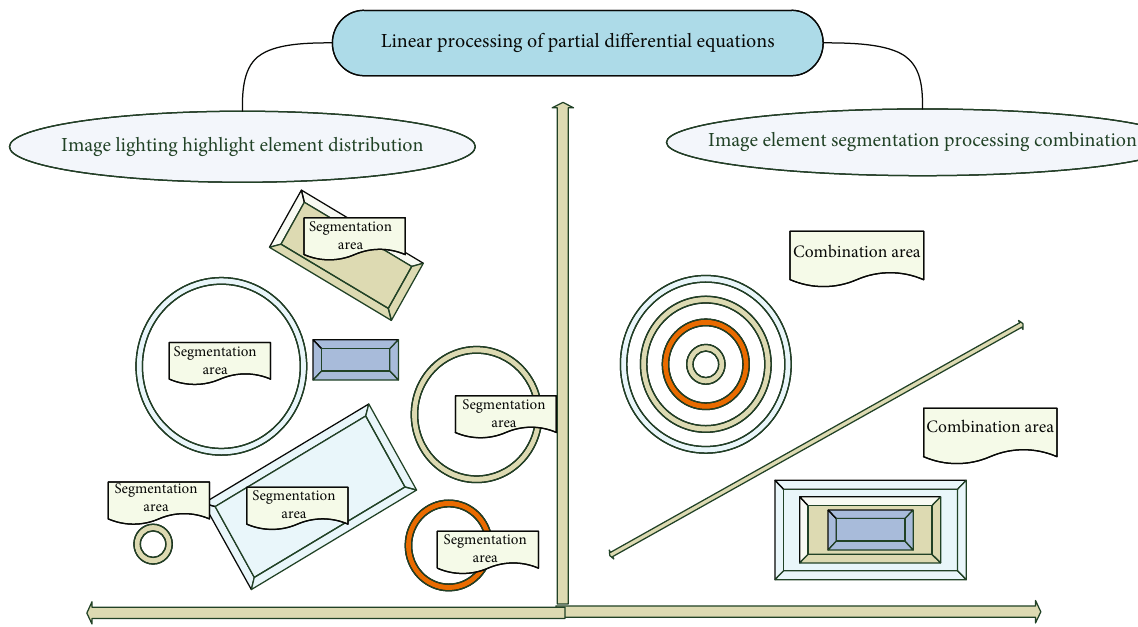
Figure 5: Schematic diagram of linear division processing of partial di ff erential equations.